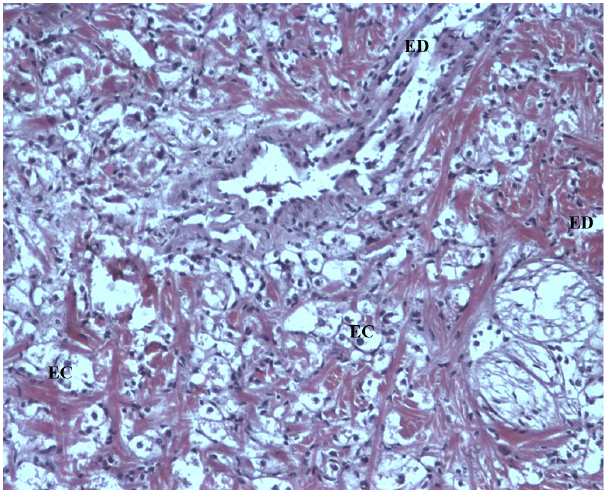
Fig. 3 Histological section of the Helix aspersa maxima snail immediately after wakening. Magnification 10×/0.25. E.C. – excretory cells, E.D. – excretory duct.